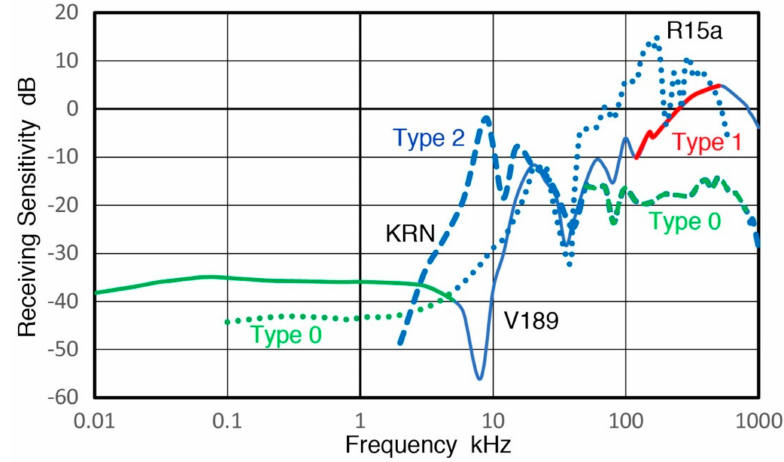
Figure 26. Three types of frequency dependence illustrated for V189 (Group D), R15a (Group R) and KRN (Group